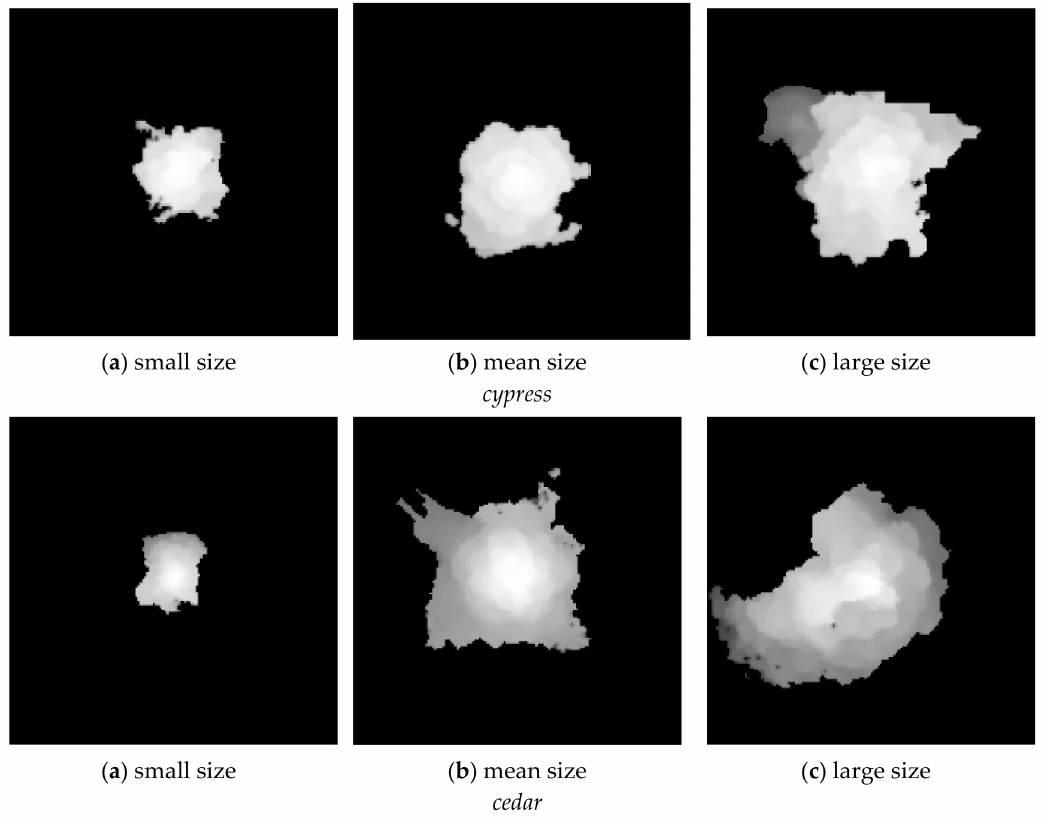
Figure 10. Examples of crown images. The pixel value of each image indicates estimated tree height in meter unit. The spatial size of each image is 161 × 161 pixels and one pixel represents 10 × 10 cm. Finally, each original image was resized to 224 × 224 pixels correspond to input data requirement of